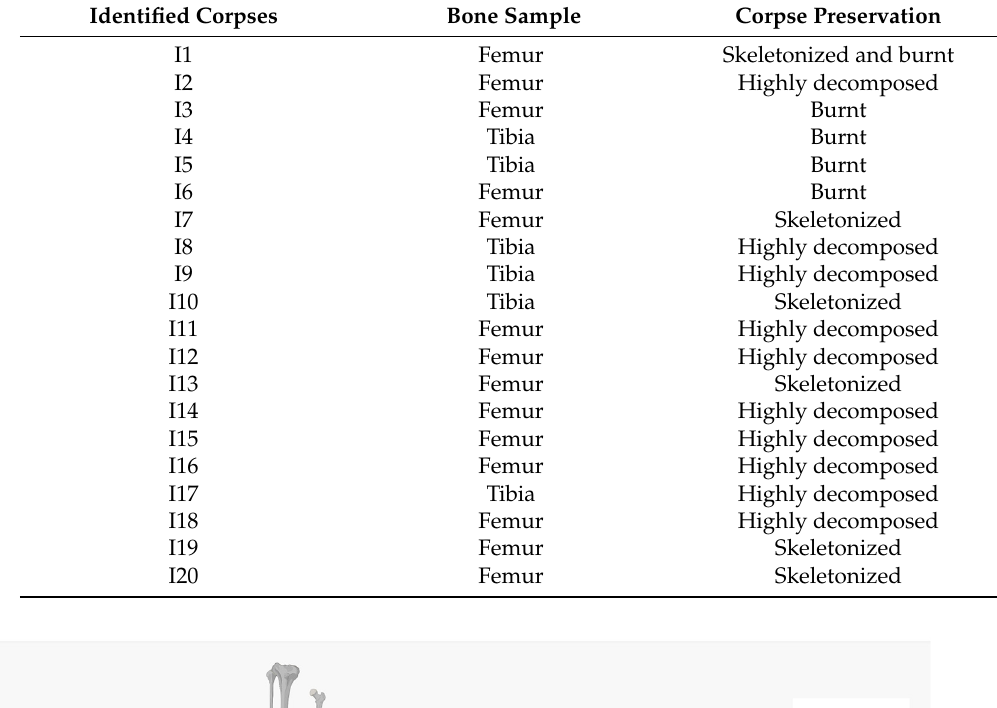
Table 1. Bone samples tested in the present work.